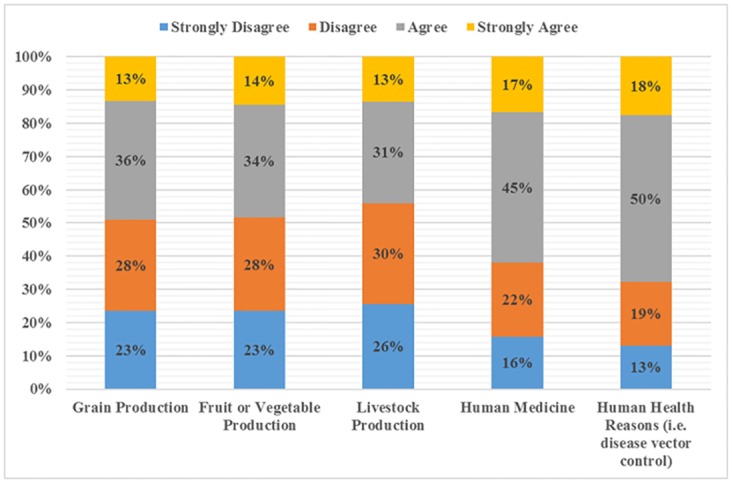
Summary of sample acceptance of GMOs across five categories/uses (n = 964).